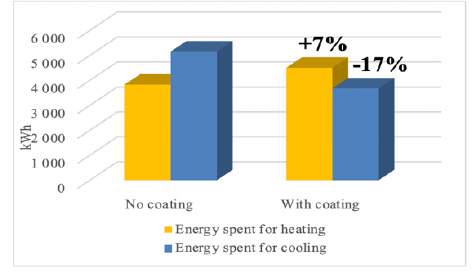
Fig. 3. Total energy consumption comparison between “No coating” and “With coating”